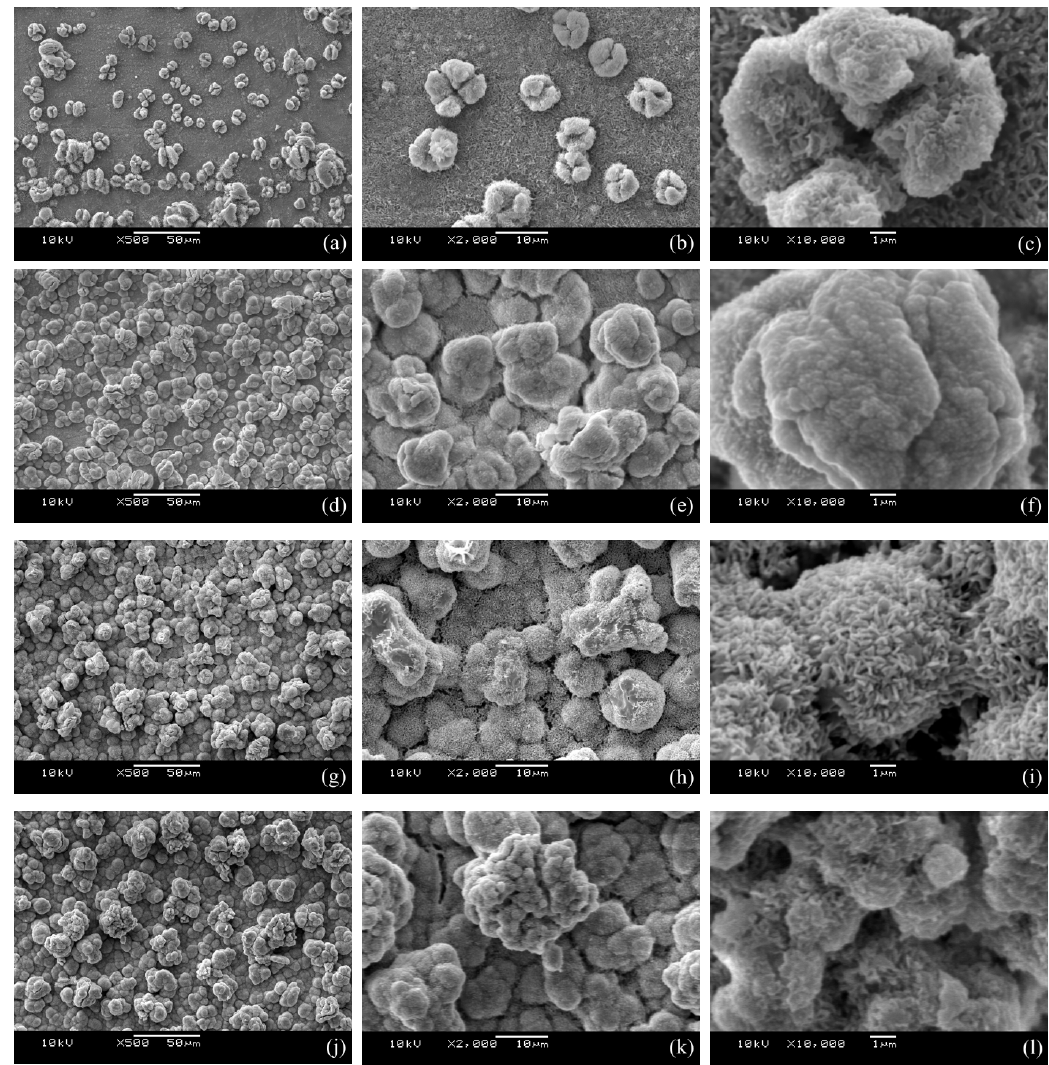
Figure 2. Scanning electron microscopy (SEM) images of the as-prepared surfaces deposited at 30 V and 1000 Hz pulse current for different duty ratio. ( a – c ) 20%; ( d – f ) 40%; ( g – i ) 60%; ( j – l ) 80%.